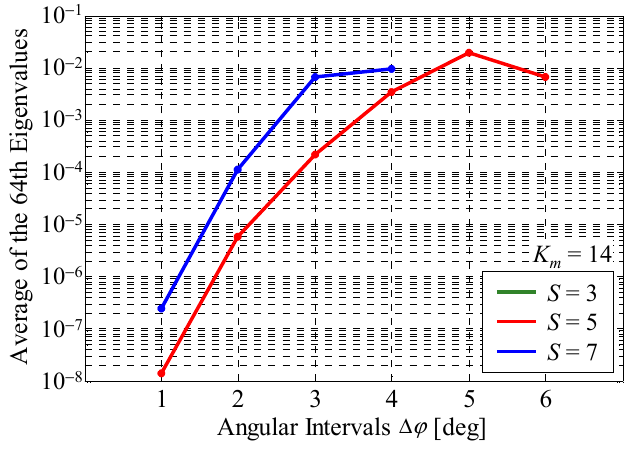
Figure 4. Average of the 64th eigenvalues.